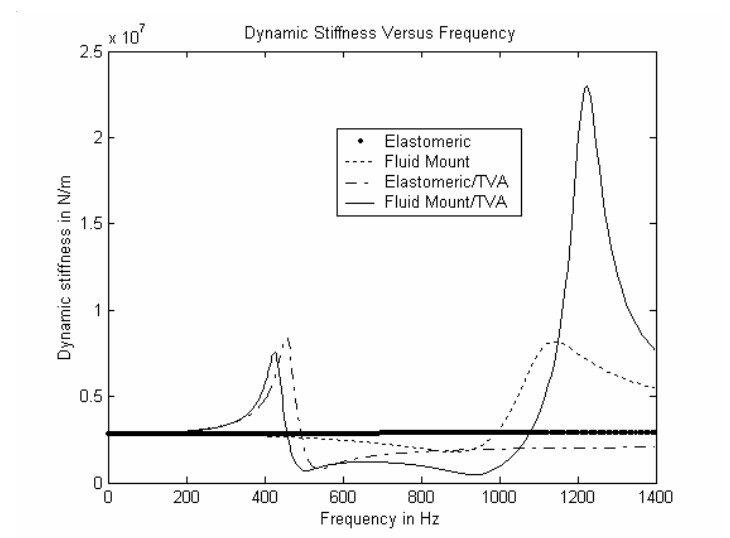
Fig. 16. Dynamic stiffness comparison of different vibration